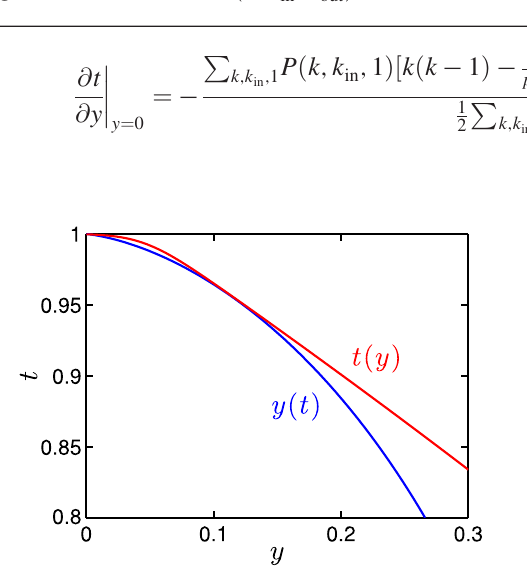
FIG. 7. Condition for a first-order phase transition. This figure shows that the functions t ð y Þ and y ð t Þ are tangential at the critical point when the transition is of the first order. Here, h k γ ¼ 3 , and the minimum degree m ¼ 2